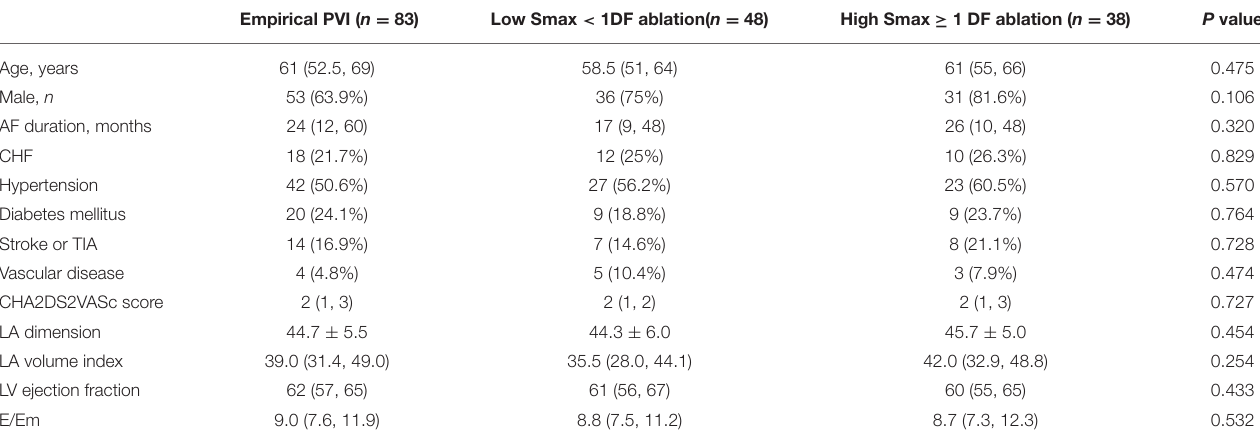
TABLE 3 | Baseline characteristics among the three ablation groups in the clinical patients.